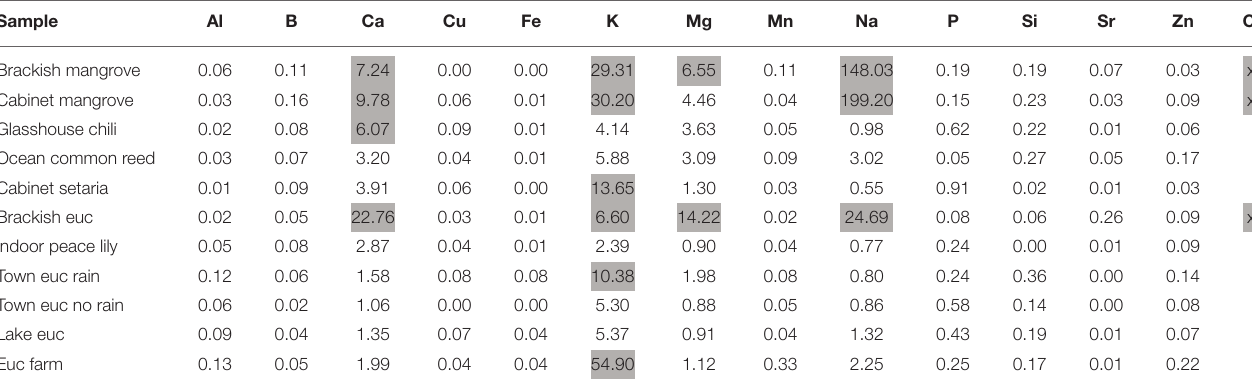
TABLE 3 | Inductively coupled plasma-optical emission spectroscopy (ICP-OES) results in µ g/g (ppm) of similar leaf area for all leaf wash samples studied. Sample